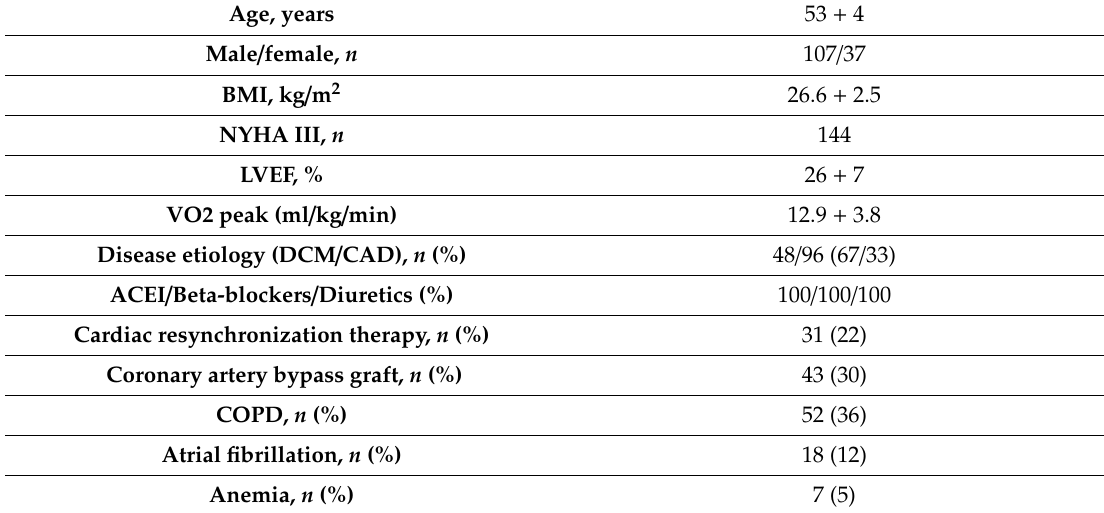
Figure 1. Study design. Skeletal muscle biopsies were taken twice from a selected group of HF patients enrolled in the personalized exercise training program as indicated: Before and after 12 weeks of training. The portion of the first biopsy was used to evaluate the regeneration potential of HF-derived skeletal muscle progenitor cells as we described recently [8]; the rest was flash frozen and saved for further histology analysis. Table 1. Baseline characteristics of patients enrolled in the study ( n =